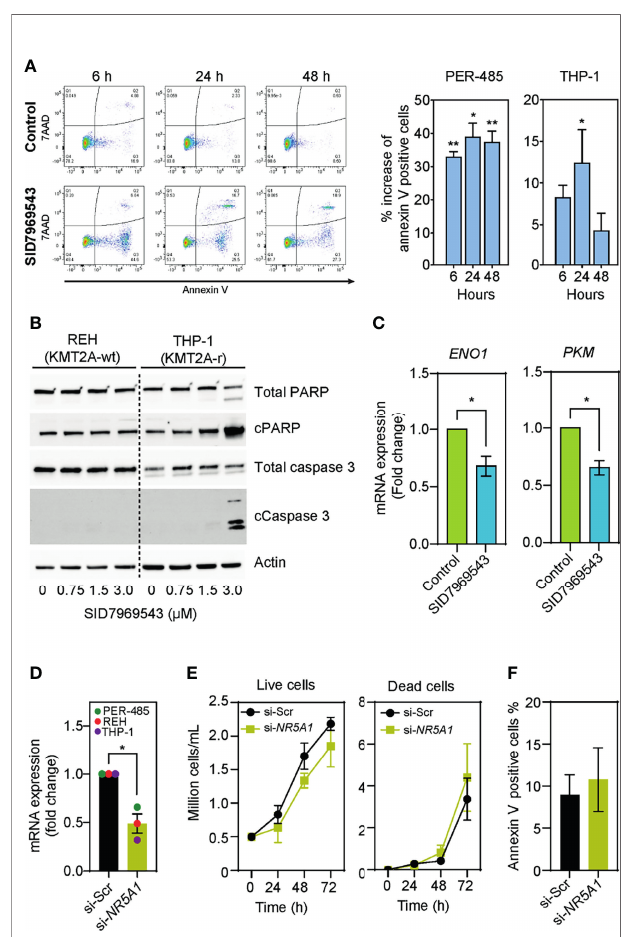
FIGURE 3 | SID7969543 induces caspase 3-mediated apoptosis in KMT2A- r leukemia cells. (A) Representative fl ow cytometry plots of PER-485 cells (left) treated with the compound for up to 48 hours and stained for annexin V/7AAD. Quanti fi cations (right) of mean percentage increases of annexin V positive PER-485 and THP-1 cells relative to vehicle-treated cells after treatment with their respective IC 50 doses of SID7969543 (PER-485: 1.4 µM; THP-1: 2.6 µM). Statistical signi fi cance was determined by one sample t-test. (B) Western blots showing induction of apoptotic markers in KMT2A-r THP-1 cells but not in KMT2A-wt REH cells after treatment with SID7969543. (C) mRNA expression level of ENO1 and PKM after treatment of KMT2A-r PER- 485 cells with SID7969543 relative to vehicle-treated cells. Cells were treated with 1.4 µM (IC 50 of for PER-485) of SID7969543 for three hours. (D) mRNA expression level of NR5A1 after a 48-hour incubation of three KMT2A-r leukemia cell lines (PER-485, REH, and THP-1) with LNP-siRNA targeting NR5A1 (si- NR5A1 ) relative to cells treated with LNP encapsulating scrambled siRNA (si-Scr). (E) Cell growth of KMT2A-r PER-485 cells treated with si-Scr LNPs (control) or si- NR5A1 up to 72 hours as determined by trypan blue exclusion cell count. (F) Percentage of annexin V positive PER-485 cells after a 48-hour treatment with si-Scr or si- NR5A1 LNPs. Graphs depict mean ± SE of three independent experiments. Asterisks represent signi fi cance levels of P-values. *, p <0.05; **, p